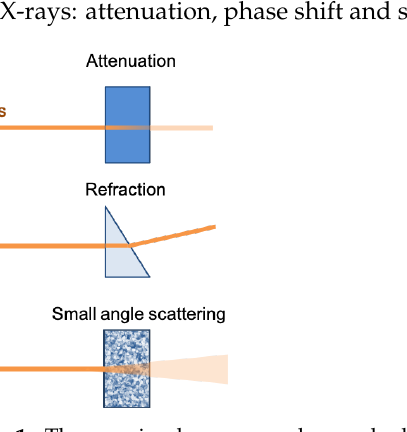
Figure 1. Three main phenomena observed when imaging a sample with X